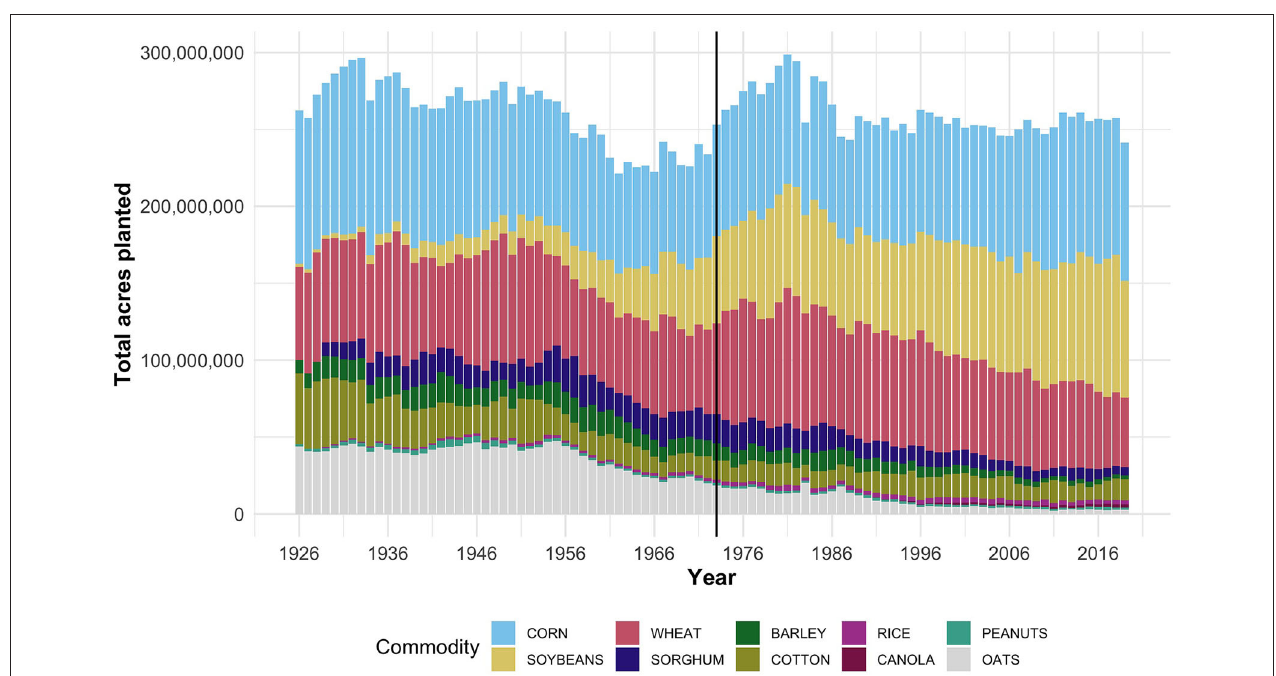
FIGURE 9 | Total acres planted of 10 major U.S. crops between 1920 and 2019. Top 10 crops determined by acres planted in 2019. A vertical line at 1973 indicates the passing of the 1973 Farm Bill and marked transition toward crop specialization. Data: USDA NASS Survey.